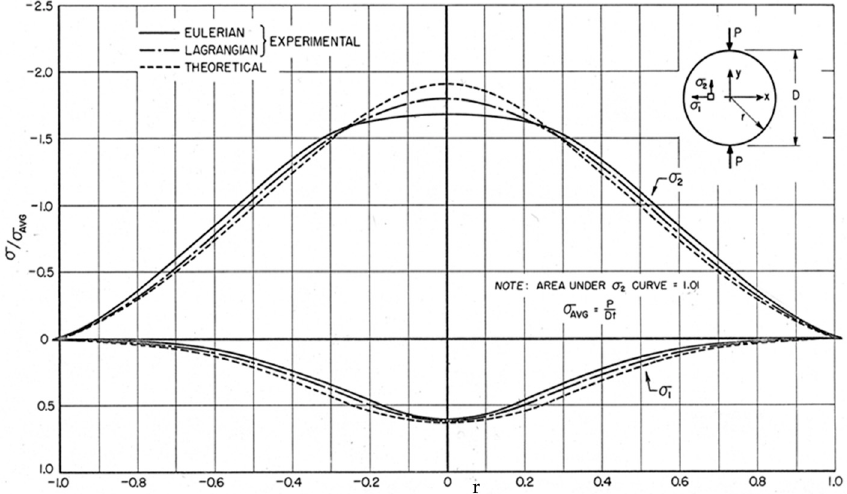
Figure 18. Comparison of experimental and theoretical distributions of principal stresses along the disk horizontal diameter.